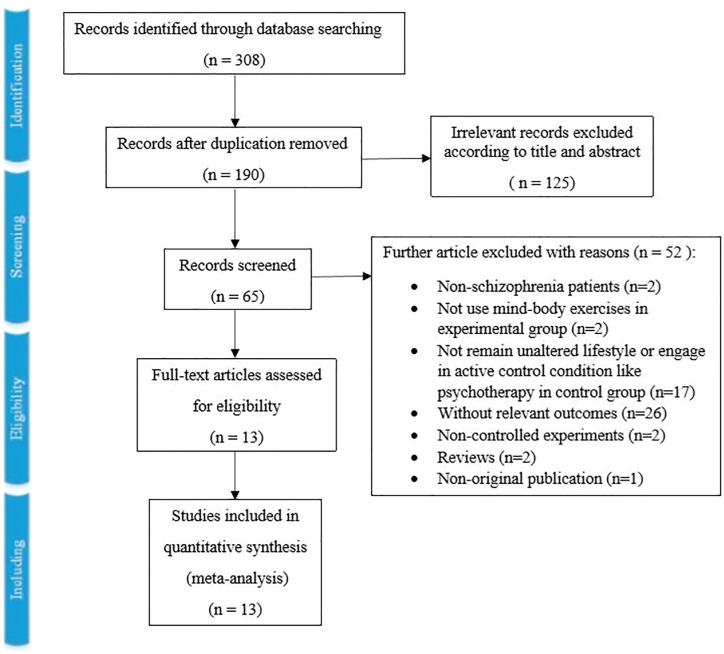
The Detailed Process of Study Selection.